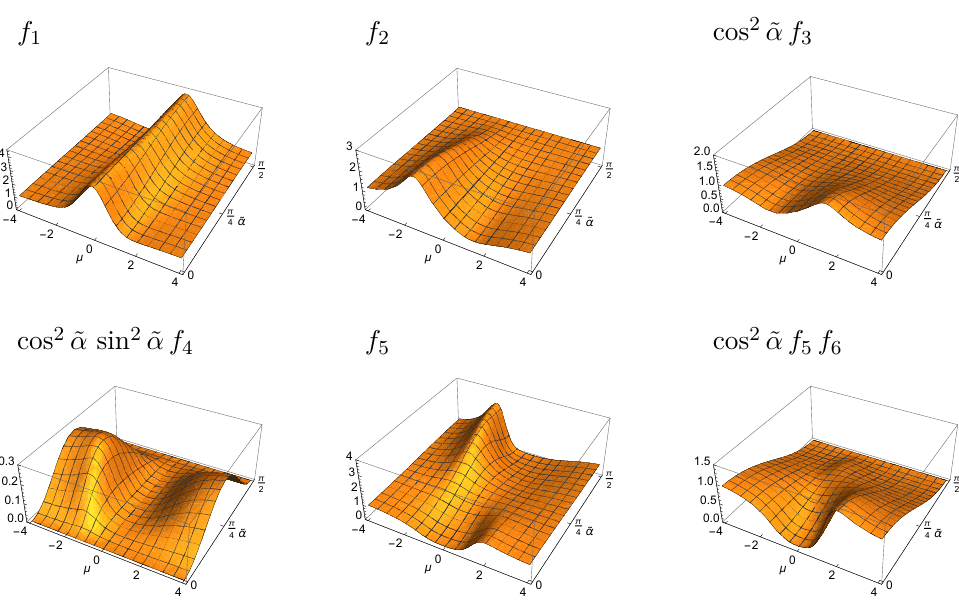
Figure 5 . Regular metric functions in (3.8) for the Janus solution with α = 1 and β = π